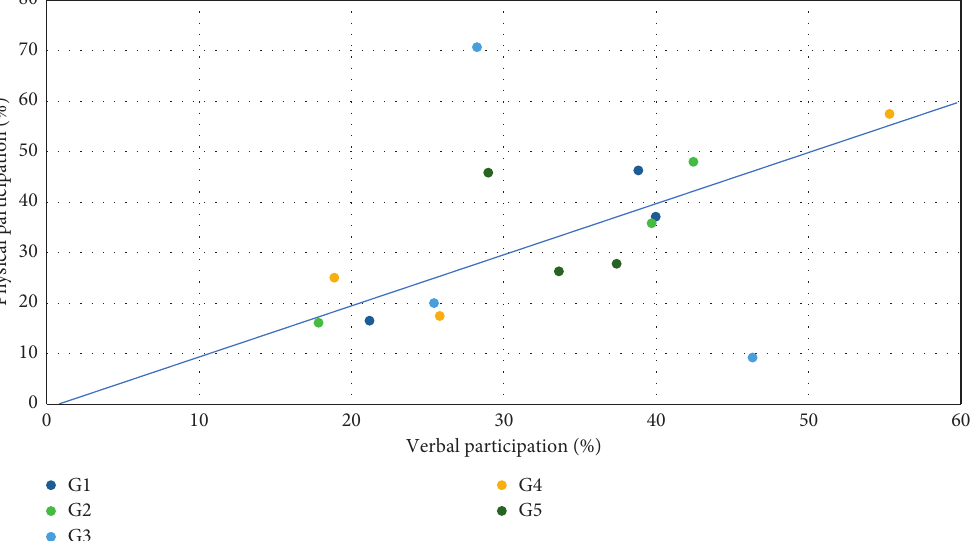
Figure 13: Relative ratio of verbal participation vs physical participation.